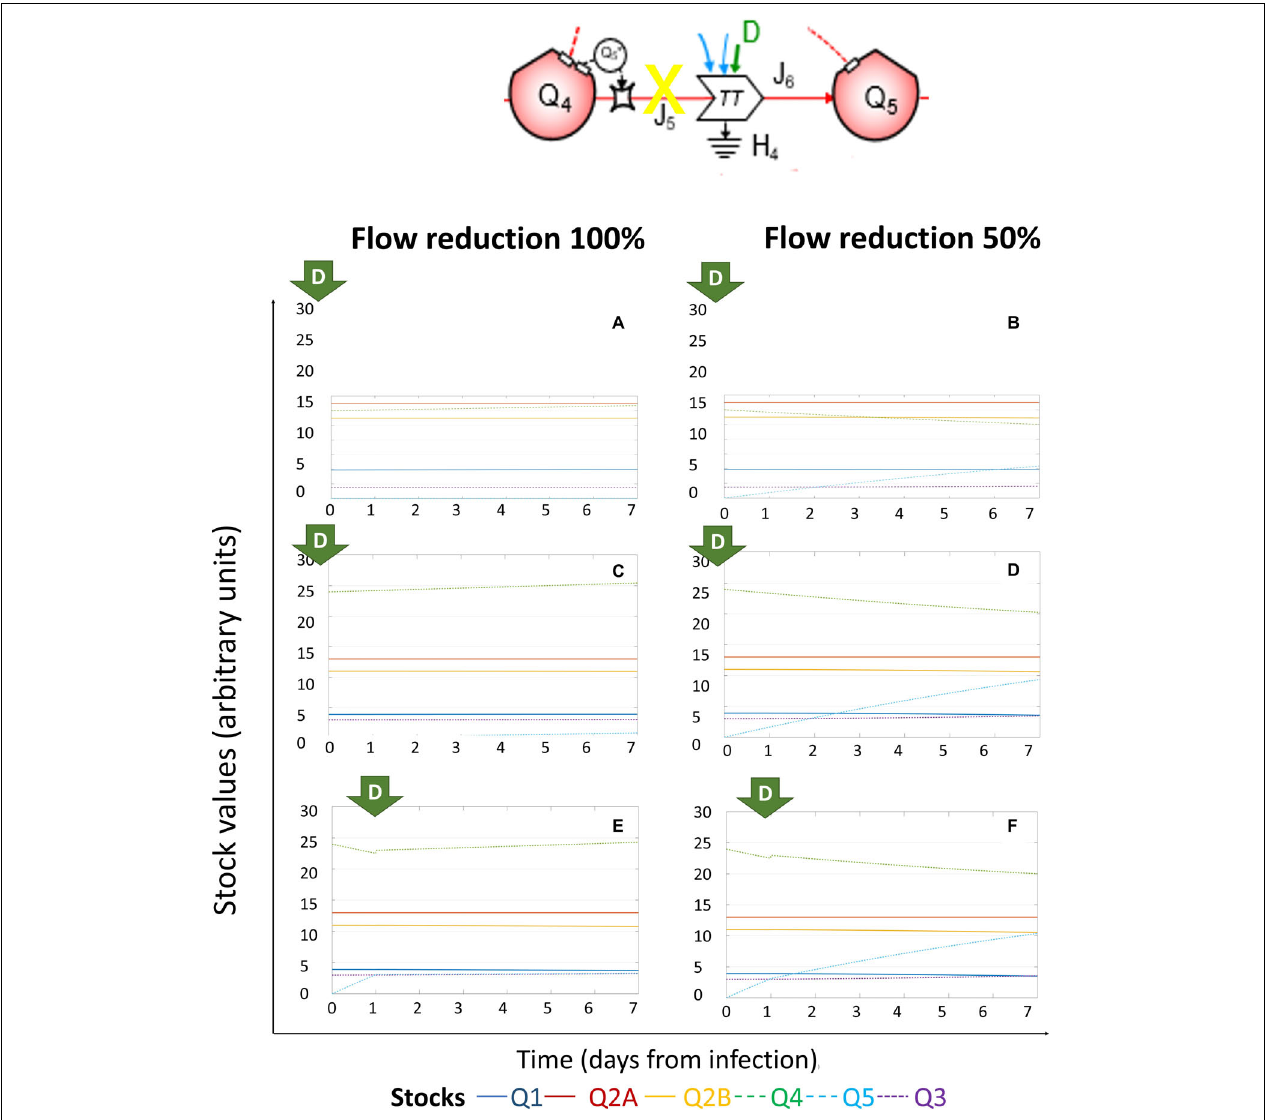
FIGURE 5 | System dynamics of (+)ssRNA virus–host interaction in response to external driving forces applied to reduce virions assembly. Changes over time of the values of each stock of the system diagrammed in Figure 1 (for the color code, see bottom), expressed in ATP-eq, in response to reduction of J 5 (flow of energy required for virions assembly). Several scenarios are shown: initial viral load 5k and application of full (100%, A ) or partial (50%, B ) J 5 reduction at Day 0; initial viral load 10k and application of full (100%, C ) or partial (50%, D ) J 5 reduction at Day 0; initial viral load 10k and application of full (100%, E ) or partial (50%, F ) J 5 reduction at Day